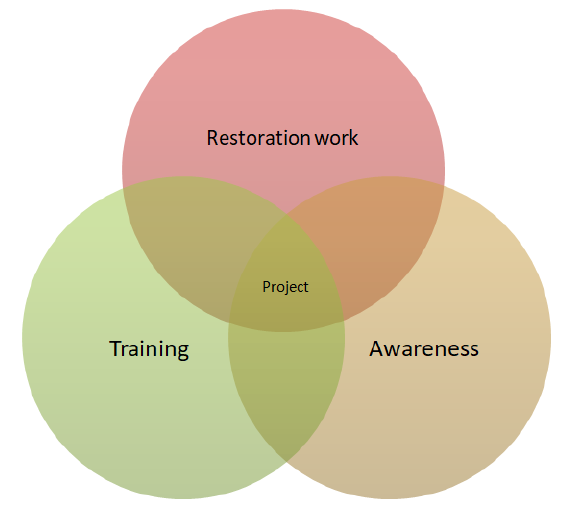
Figure 3. Diagram of strategic guidelines of the project.